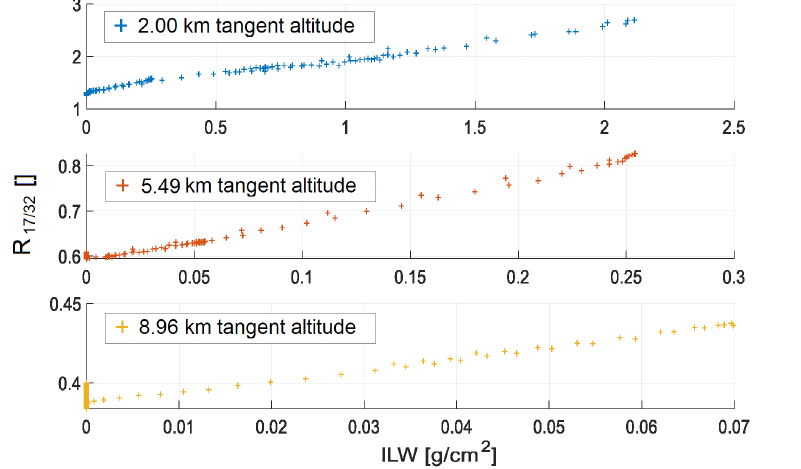
Figure 12. Scatter plots between ILW and R 17/32 for the three tangent